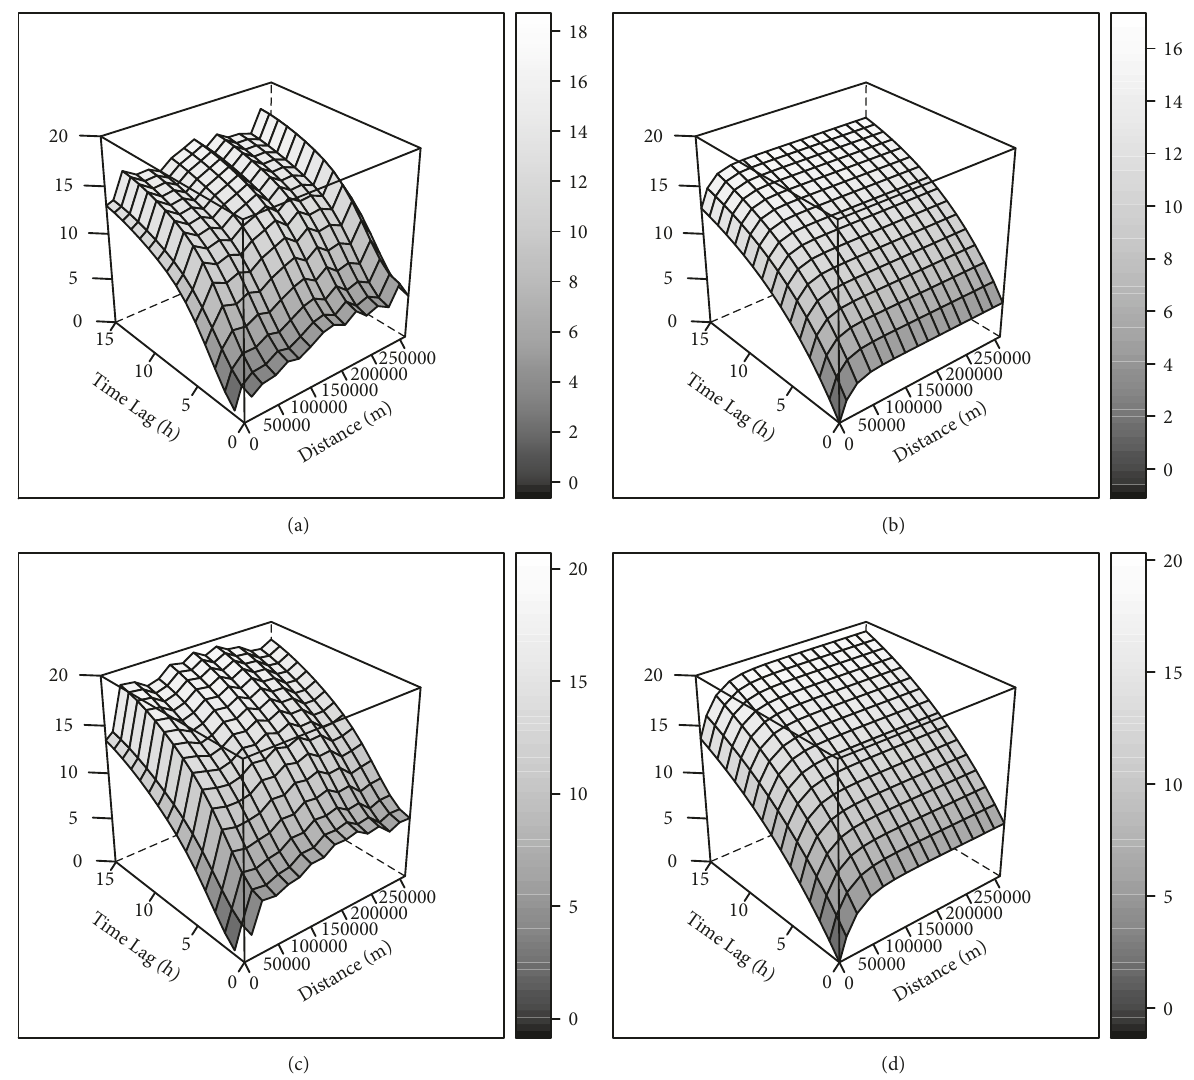
Figure 6: Spatiotemporal variograms. (a) Empirical variogram of Nov 2014. (b) Fitted variogram of Nov 2014. (c) Empirical variogram of Jan 2015. (d) Fitted variogram of Jan